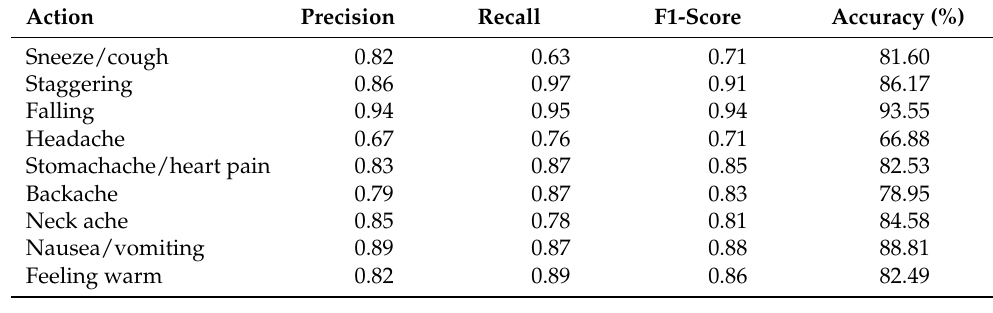
Table 6. Classification report of STGCN of healthcare-related actions in the X-sub subset.